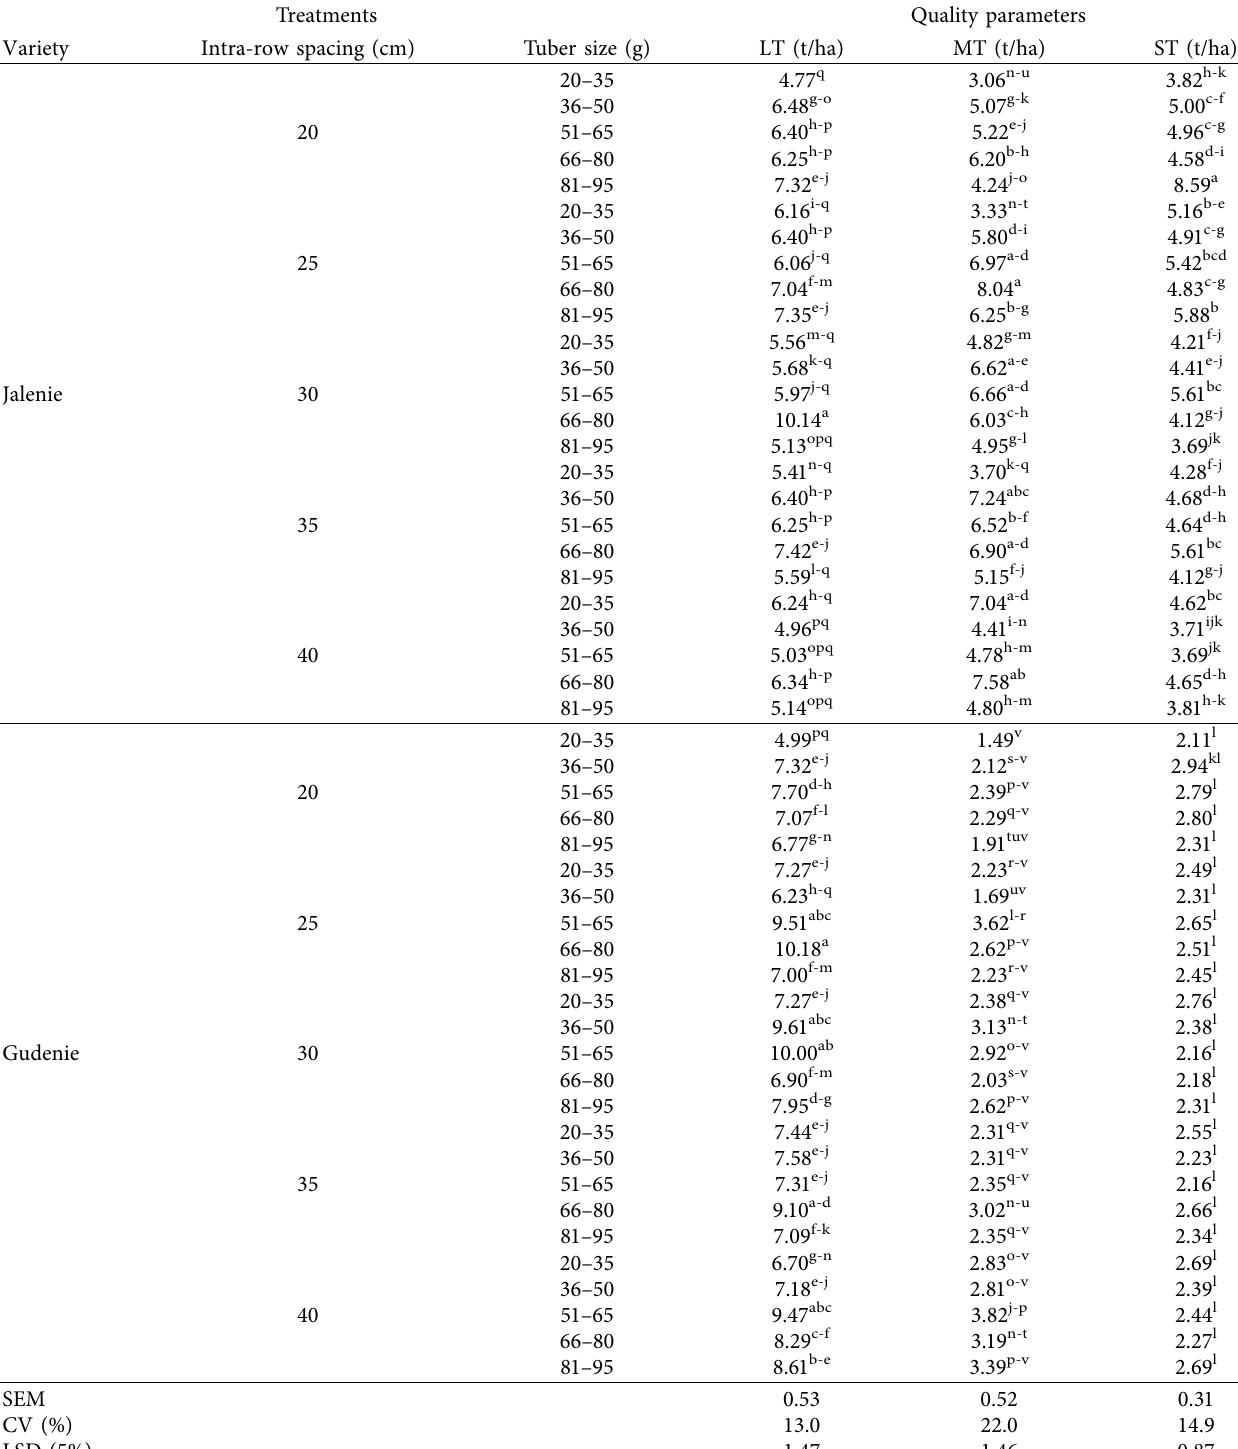
Table 7: Interaction effects of variety, intra-row spacing, and tuber size on quality-related parameters of potato in 2013/2014 at Nono